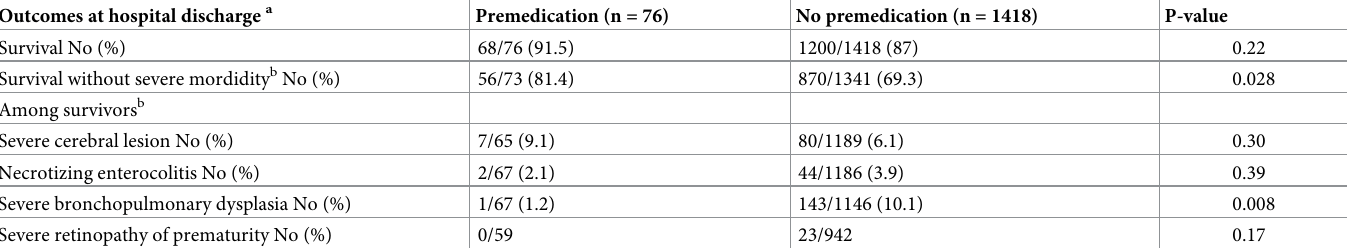
Table 3. Univariate analysis of survival and major neonatal morbidities 1 between premedicated and non-premedicated